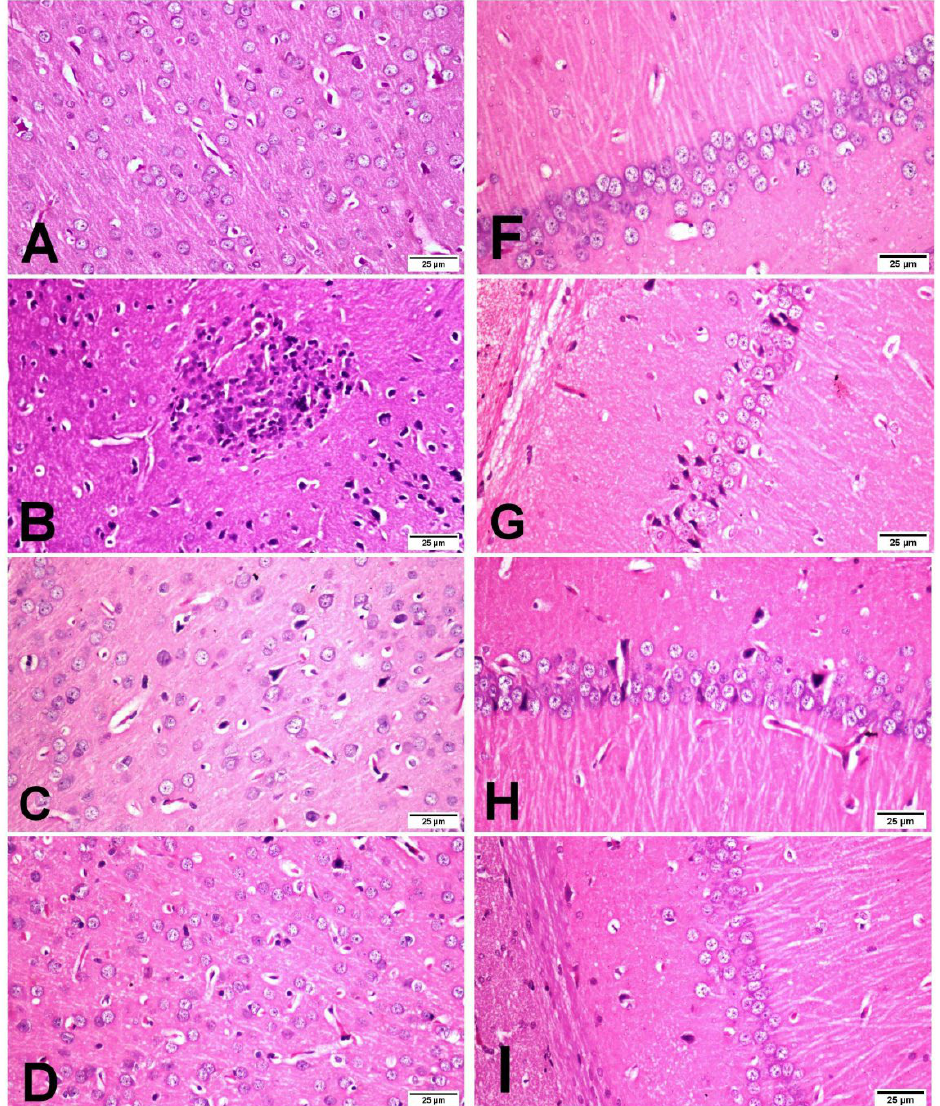
Figure 4. Effect of beta -carotene on histopathology and neuronal ischemic damage in cerebral cortex and hippocampus areas in focal cerebral ischemia-reperfusion model × 400. ( A – D ) Cerebral cortex. ( F – G ) Hippocampus. ( A ) Sham rats showing normal histological findings of the cerebral cortex. ( B ) I/R control group showing focal area of coagulative necrosis with gliosis and the surrounding neuron show neuronal degeneration. ( C ) βCAR -10 and ( D ) βCAR -20 groups showing marked reduction in the number of degenerated neurons. (F) Sham group showing normal histologic picture of brain hippocampus. ( G ) I/R control group showing pyramidal cell loss with numerous pyramidal cell necrosis. ( H – I ) βCAR - 10 and βCAR -20 groups showing marked reduction in pyramidal cell necrosis and loss. Scale bar 25 µm.